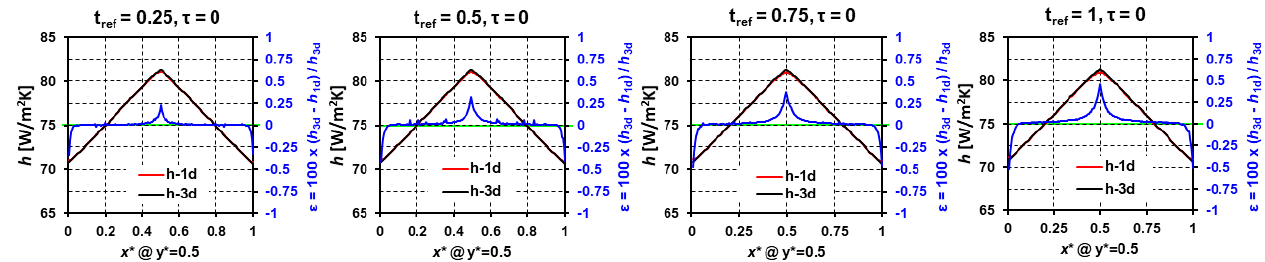
Figure 15. Method D, Case I: Local h variation at surface centerline and their relative % differences (Re ‐ 20,000, τ = 0).